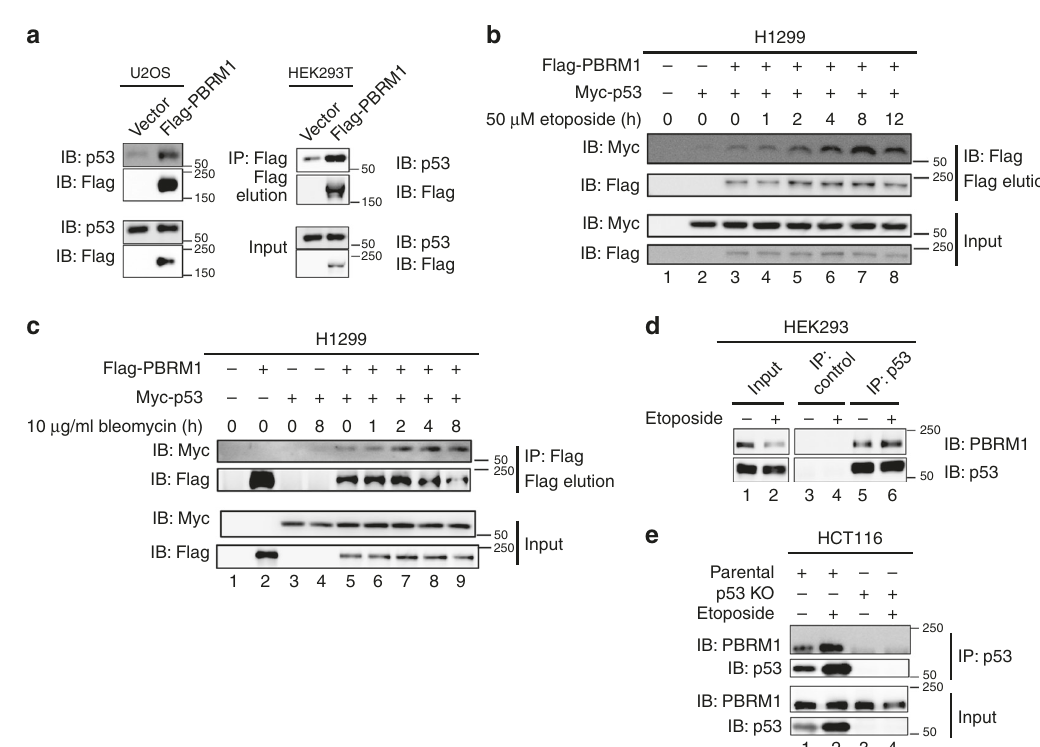
Fig. 1 PBRM1 and p53 display a physical association that is enhanced after DNA damage. a U2OS cells (left) and HEK293T cells (right) were transfected with vector or Flag-PBRM1 and harvested for immunoprecipitation with Flag-M2 beads and elution with 3X Flag peptide. Inputs and eluates were analyzed by immunoblots. b , c H1299 cells were transfected with Flag-PBRM1 and Myc-p53 and treated with etoposide (50 μ M, b ) or bleomycin (10 μ g/ml, c ) for the indicated times. Lysates were subjected to immunoprecipitation with Flag-M2 beads. Inputs and eluates were analyzed by immunoblots. d HEK293 cells were treated with vehicle (DMSO) or etoposide (50 μ M) for 8 h and harvested for immunoprecipitation with control IgG and p53 antibodies. The bound PBRM1 and p53 were examined by immunoblots. e HCT116 and HCT116 p53 − / − cells were treated with DMSO or 50 μ M etoposide for 24 h. Lysates were immunoprecipitated with p53 antibody. The bound PBRM1 and p53 were examined by immunoblots. Source data are provided as a Source Data fi